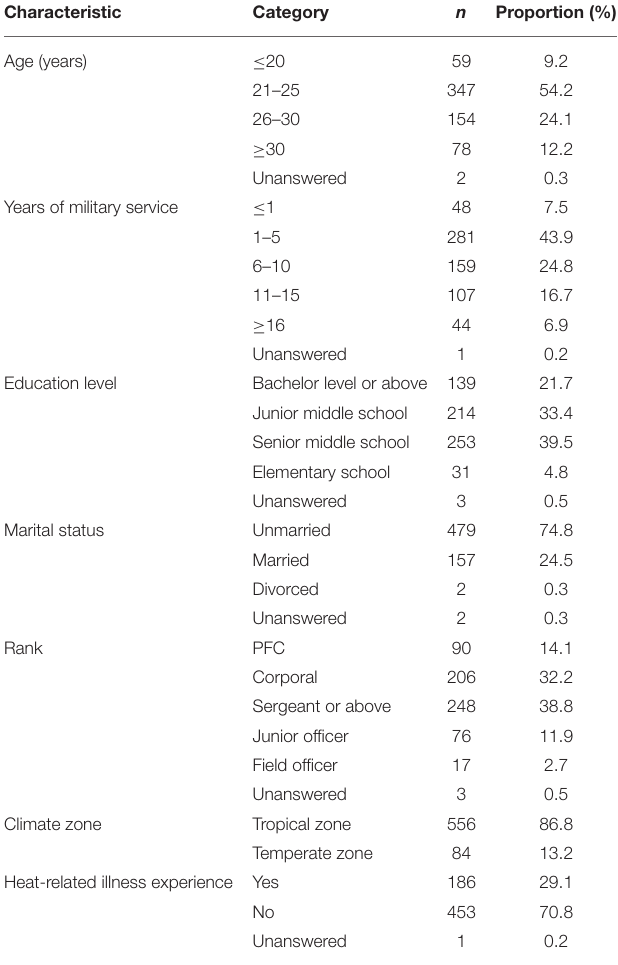
TABLE 1 | Demographic characteristics ( n =